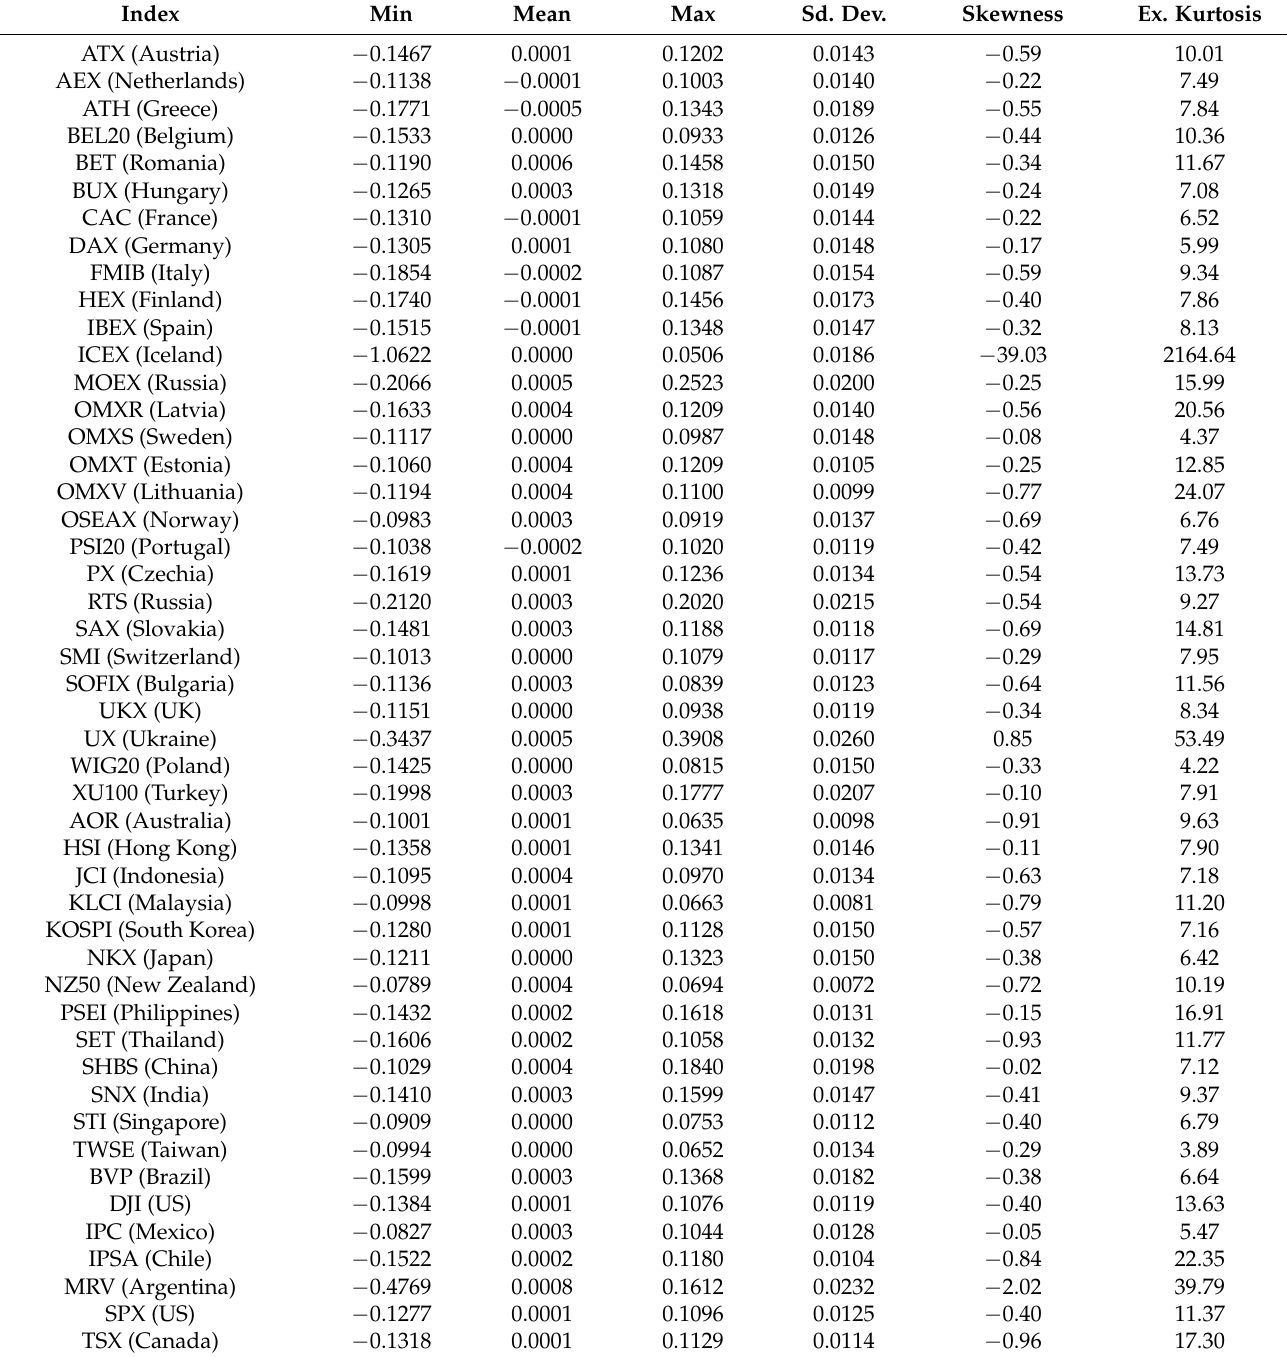
Table 1. Summary statistics for the sample of